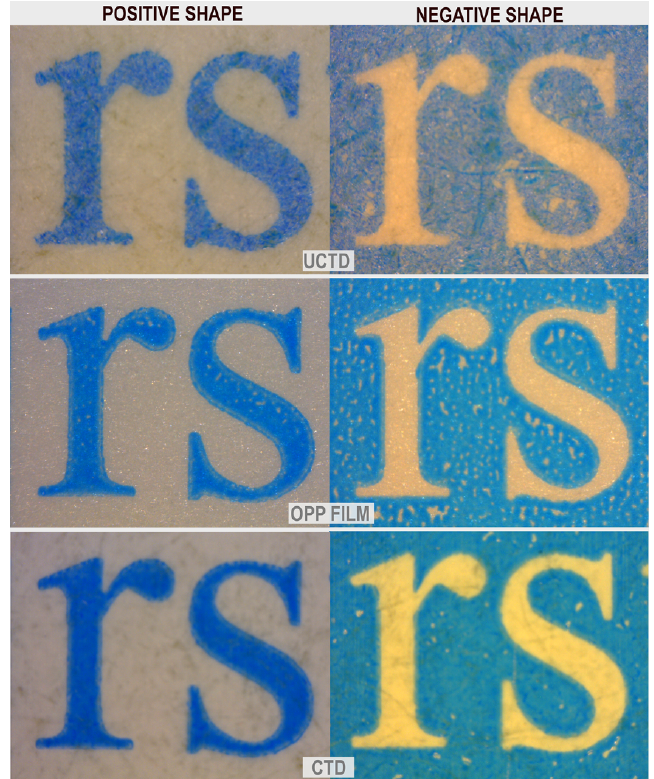
Figure 8. Visual comparison of edge degradation for text size of 8 pt printed in positive and negative shapes on three different printing